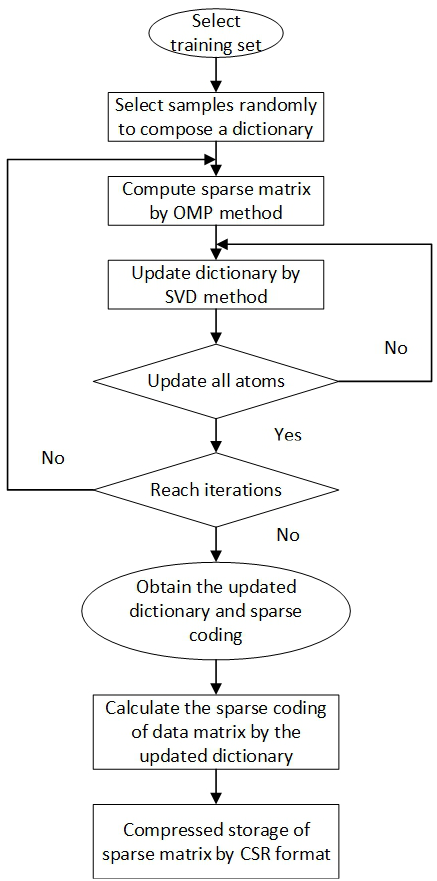
Figure 1. Process of the dictionary learning compression